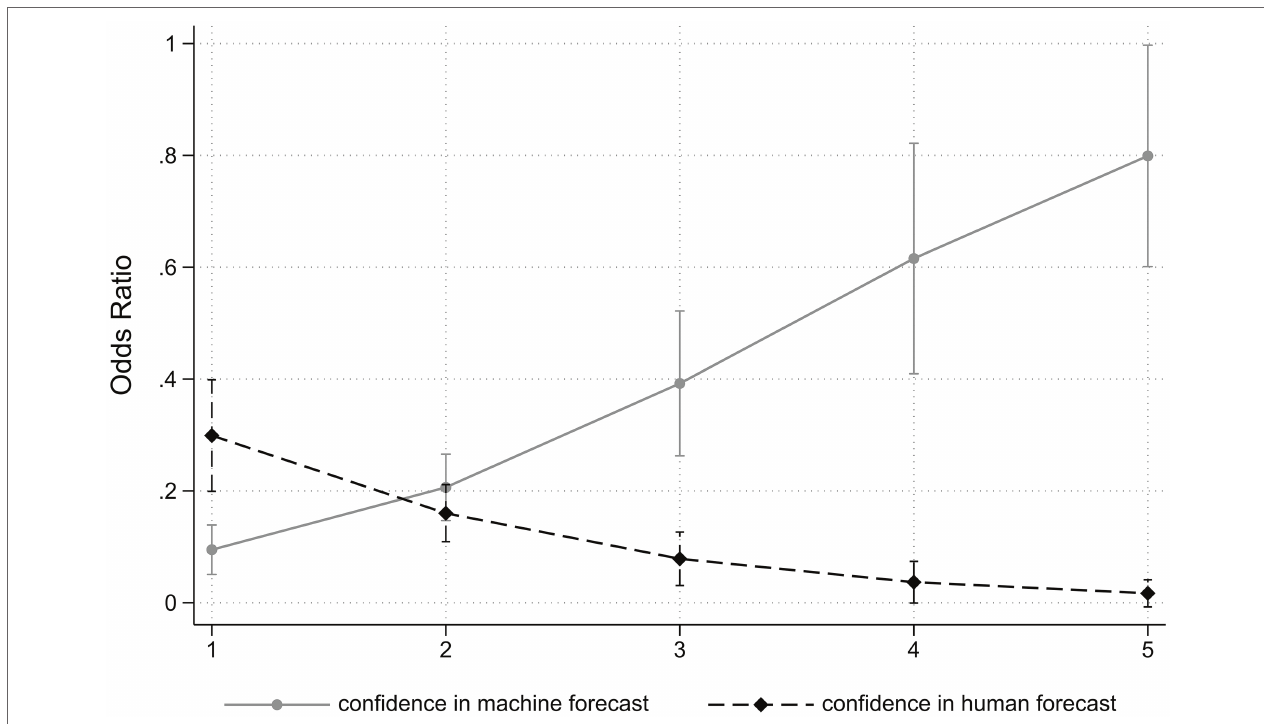
FIGURE 3 | Marginal effects plot of confidence in human (CIH) and machine (CIM) forecast on choice to delegate HR decision to